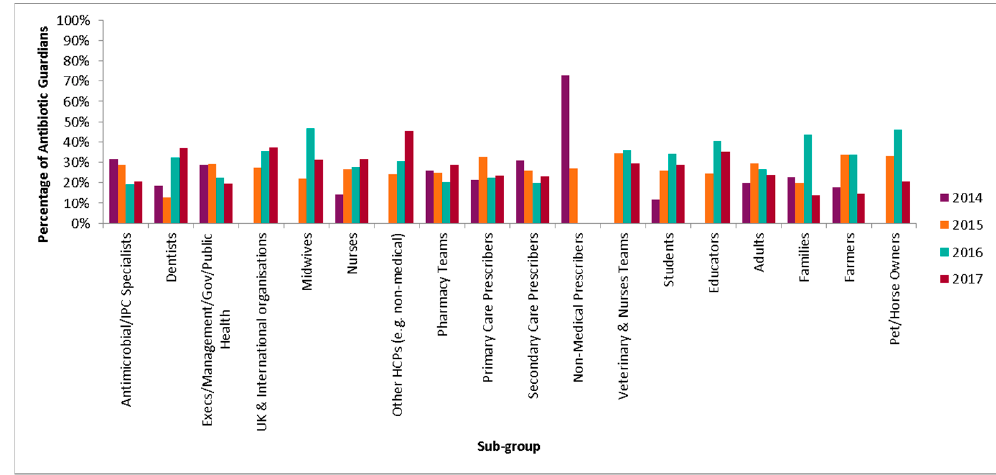
Figure 4. Percentage of AG pledges by sub-group from 2014–2017 (n = 56,721).